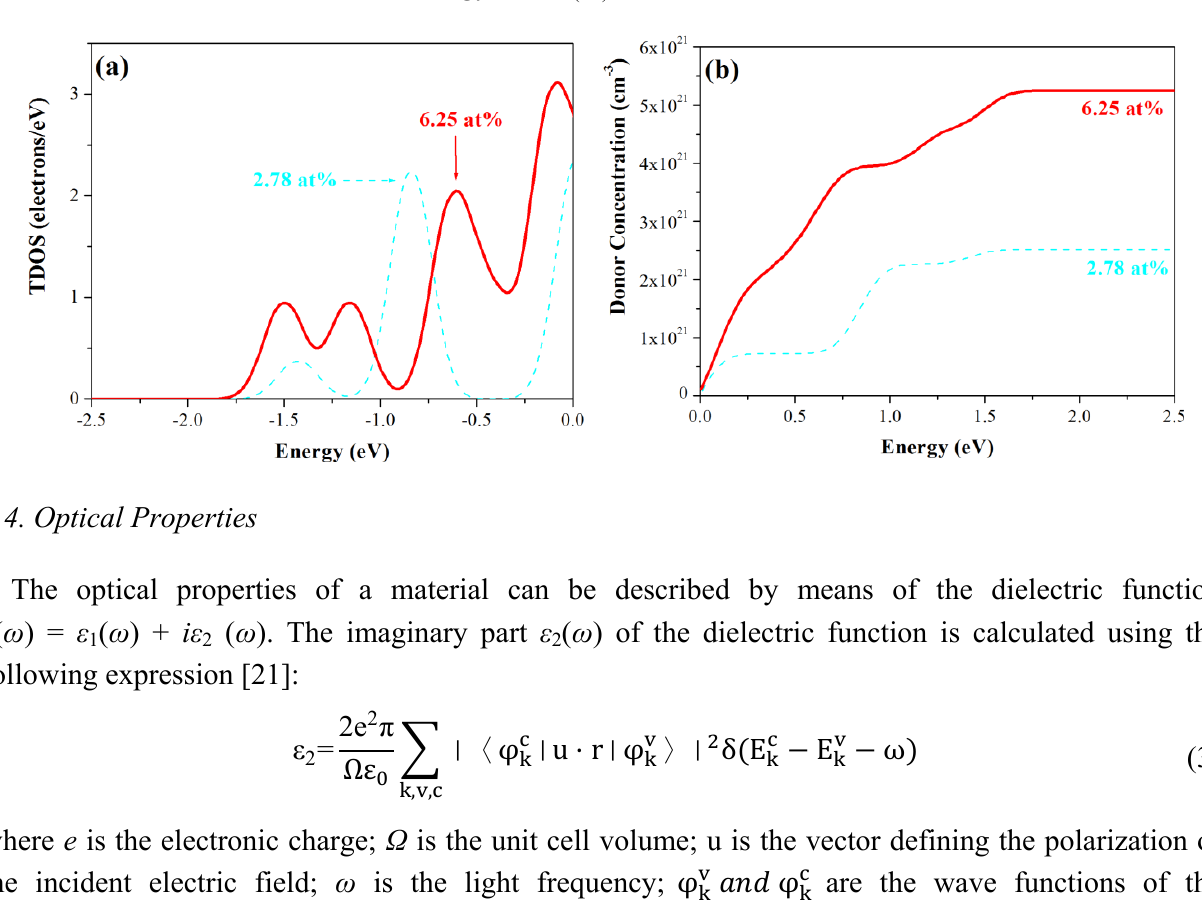
Figure 6. ( a ) Occupied states near the bottom of the conduction band; ( b ) donor concentration under different energy for Si